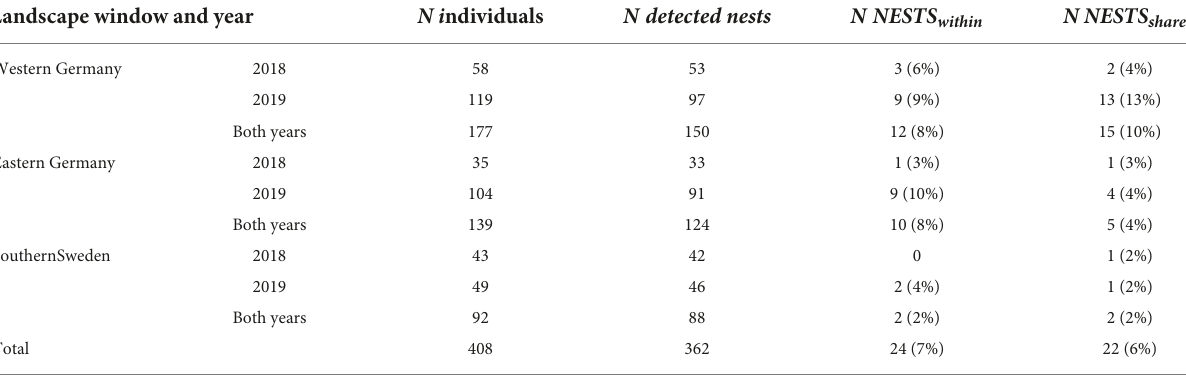
TABLE 5 Summary of full-sibship assignment (COLONY 2.0) for B. pascuorum for three landscape windows and 2 years. Landscape window and year N i ndividuals N detected nests N NESTS within N NESTS